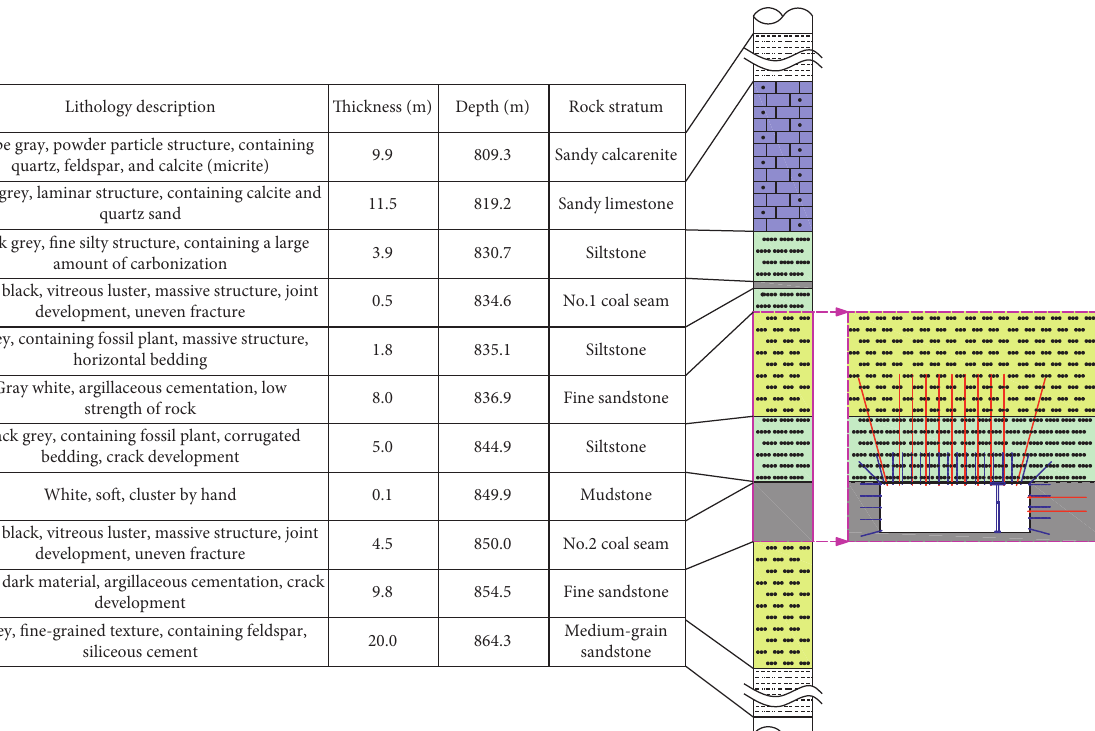
Figure 2: Lithologic distribution of the borehole histogram of the test site.